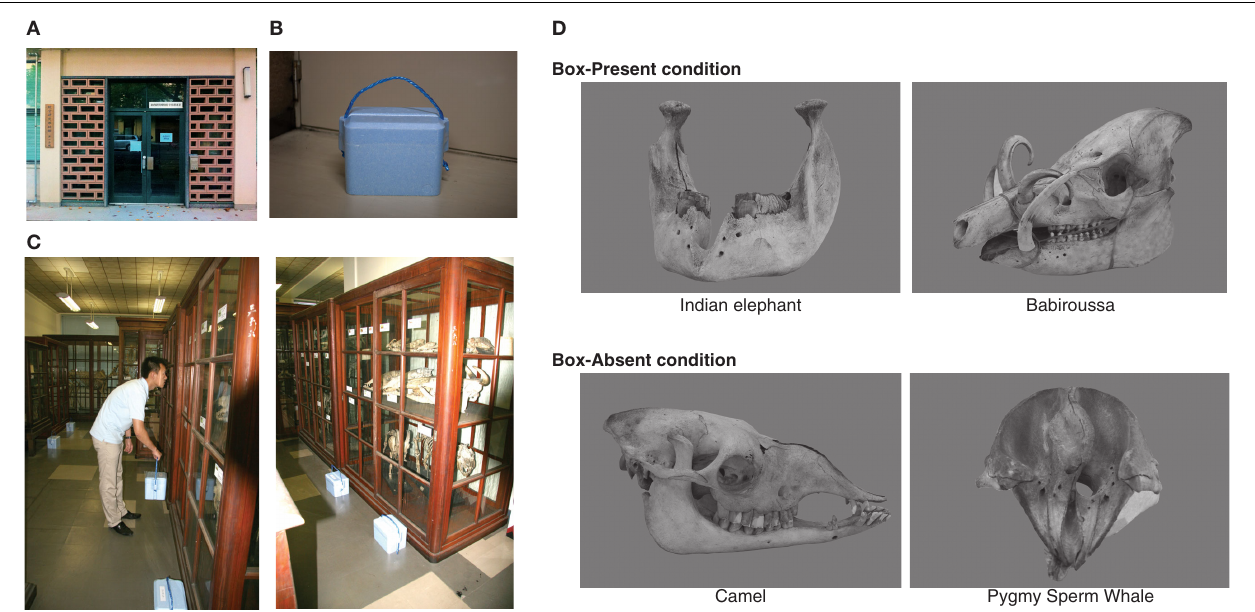
FIGURE 1 | (A) Appearance of the first pavilion of The Kyushu University Museum. (B) A box of the weight cue used in the experiment. (C) Layout and use of the weight cues. (D) Examples of skeletal preparations used in the experiment.